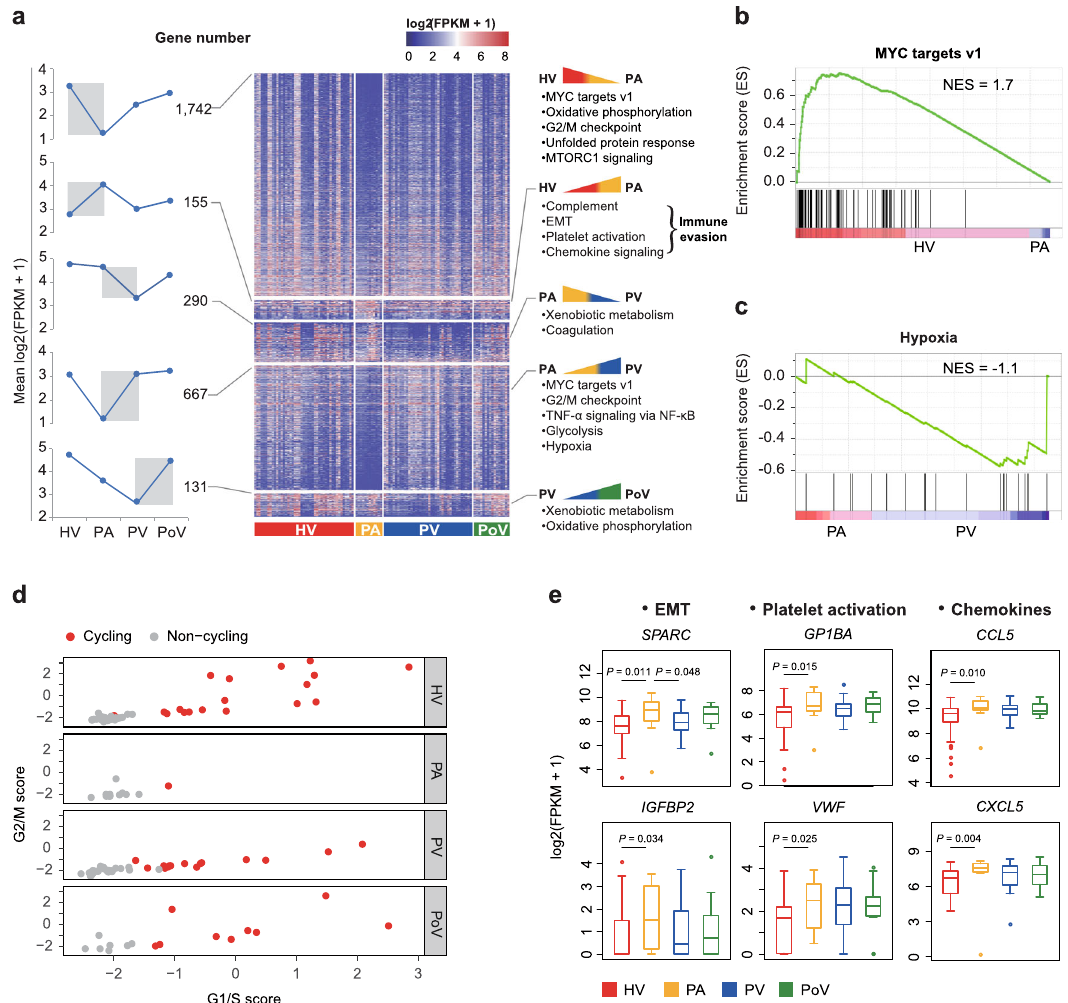
Fig. 3 Dynamics of single-CTC transcriptome highlights pathway alterations for stress response and heterogeneity in cell cycle during circulation. a Dynamic changes and heat map of differentially expressed genes between neighbor vascular sites (HV vs PA, PA vs PV, and PV vs PoV), with the number of differentially expressed genes indicated at left panel and major signaling pathways enriched (right panel). b GSEA of CTCs from HV vs PA for MYC targets v1 pathway. c GSEA of CTCs from PA vs PV for hypoxia pathway. d Scatterplot indicating cell cycle state of individual CTCs on the basis of G1/S ( x - axis) and G2/M ( y -axis) gene sets in different vascular compartments. e Box and whisker plots showing expression variance of EMT-related, platelet activation, and chemokine genes in CTCs across four vascular sites. Data are presented as median, lower quartile, upper quartile, minimum, and maximum values. n = 45 cells in HV; n = 12 cells in PA; n = 40 cells in PV; n = 16 cells in PoV. The two-sided Wilcox test